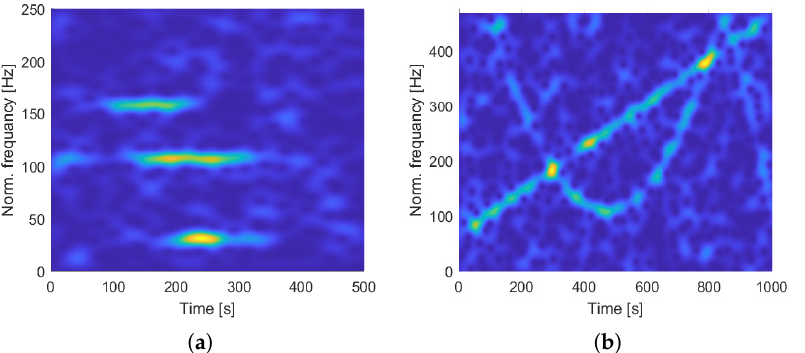
Figure 8. Entropy maps obtained by applying the 2DLEM method with the Shannon entropy for SNR = 0 dB. ( a ) Entropy map for the first signal. ( b ) Entropy map for the second signal.